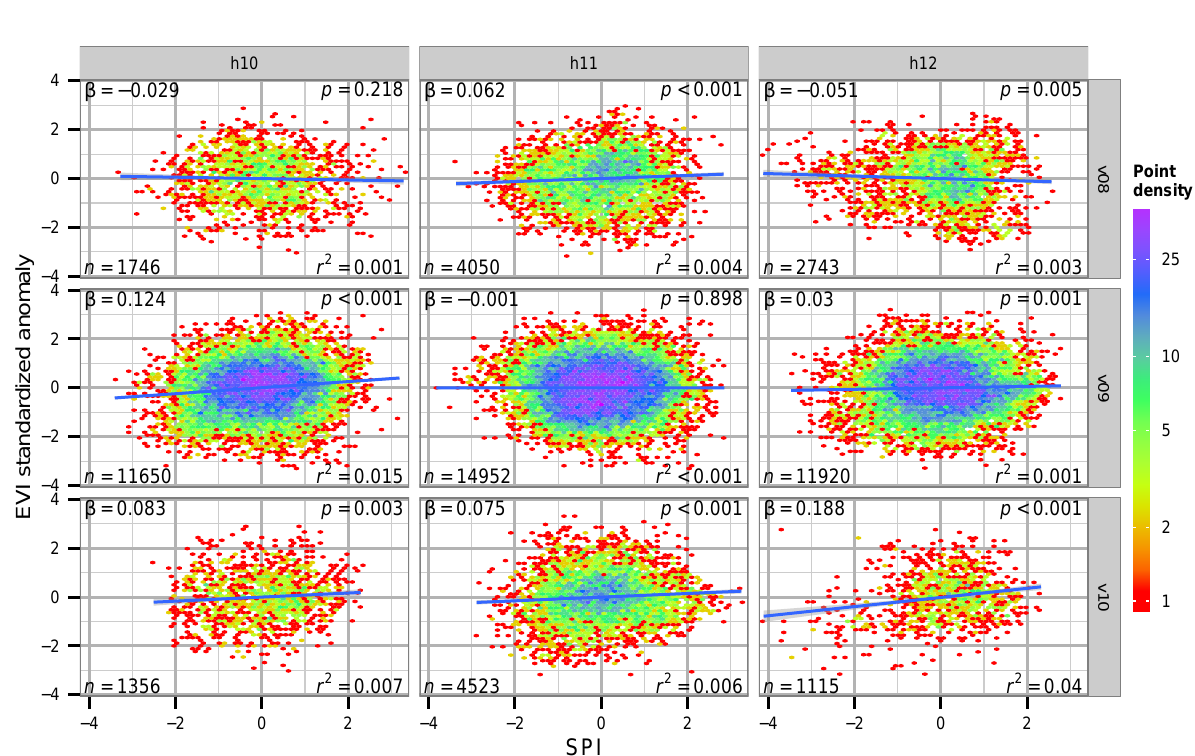
Figure 6: Same as Figure 4, but for